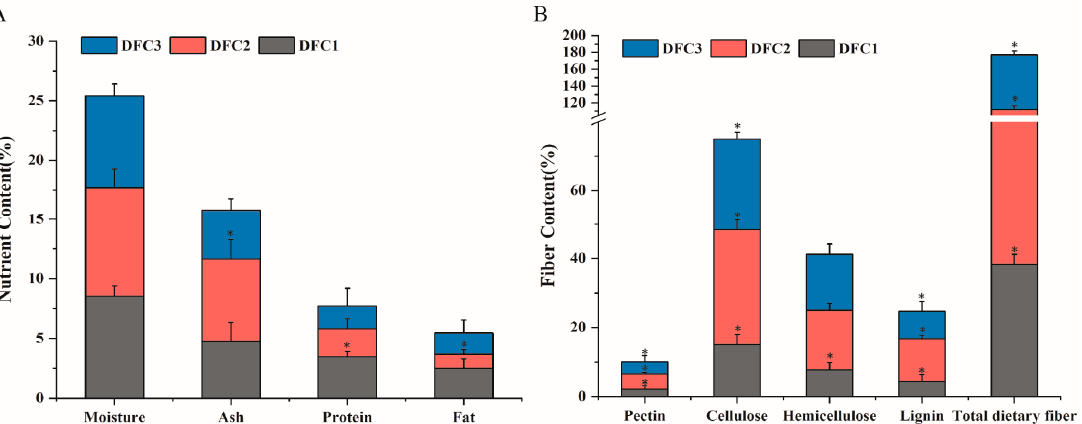
Figure 1. ( A ) Basic nutrient content of different DFCs. ( B ) Various types of fiber content of different DFCs. *: p < 0.05, significance of nutrient or fiber content between different DFCs in the same column.